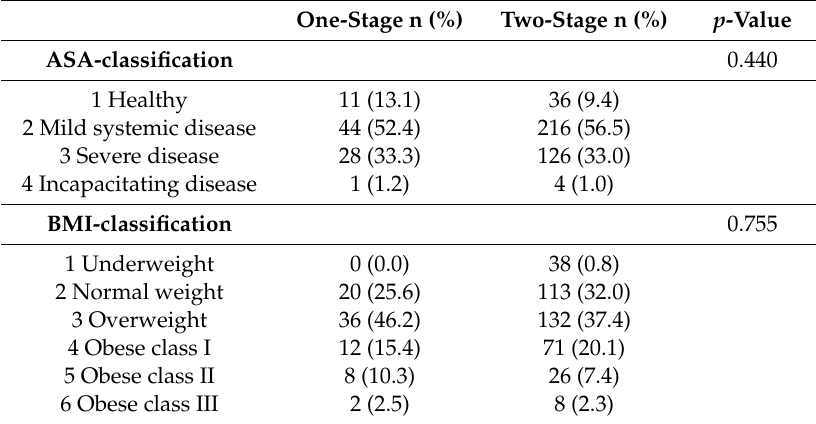
Table 3. The distribution of the American Society of Anesthesiologists (ASA) score and body mass index (BMI) in registered cases,